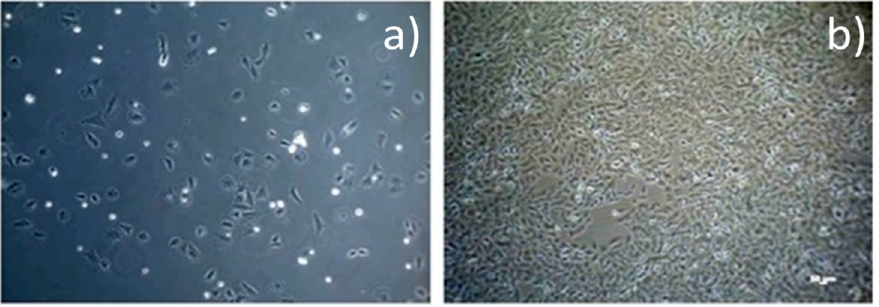
Figure 1. Optical microscopy image of osteoblasts evolution ( a ) day 1, culture medium; ( b ) 80% confluence.